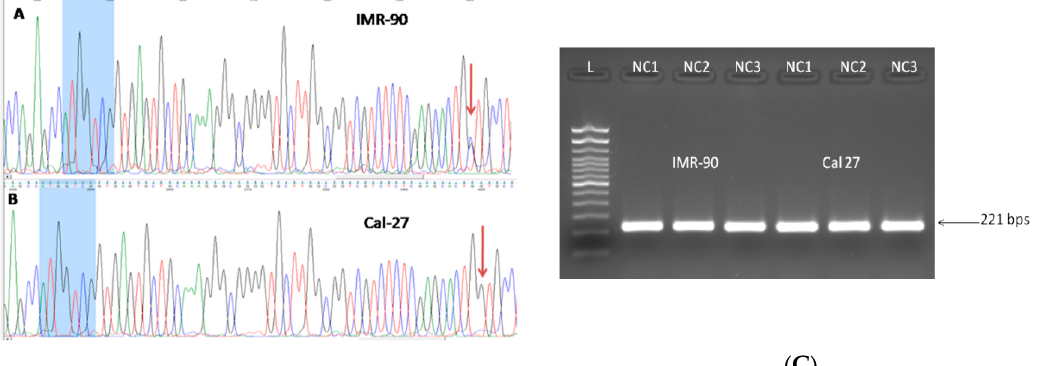
Figure 7. A . Single nucleotide variation C + G wass present in IMR-90, in NQO1 intron 1. The terminal part of the 3' exon 1 is shown in blue. The distance between the polymorphic locus, revealed to be rs 689,460 according to NCBI, and 3' of exon 1, is only 50 nts. B . All three cancer cell lines were homozygos, rs 689,460 G + G, as shown here, for Cal 27. C . Single nucleotide variant C + G in IMR-90 did not influence the NQO1 splicing. The amplicons obtained in IMR-90 under given conditions did not di ff er from those obtained in homozygos (G + G) cancer cell lines (only Cal 27 is shown). L: 100 bp DNA ladder. Lines 1–3 and lines 4–6: IMR-90 and Cal 27 under NC1, NC2 and NC3, respectively.